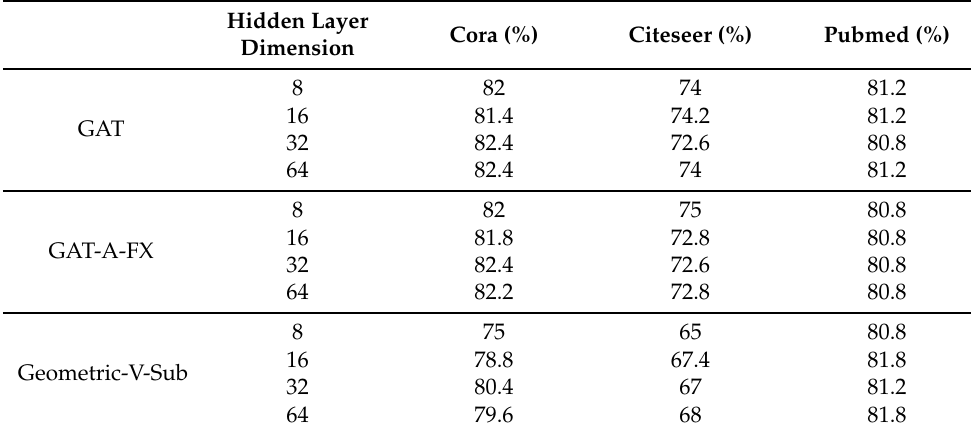
Table 2. Accuracy comparison in transductive